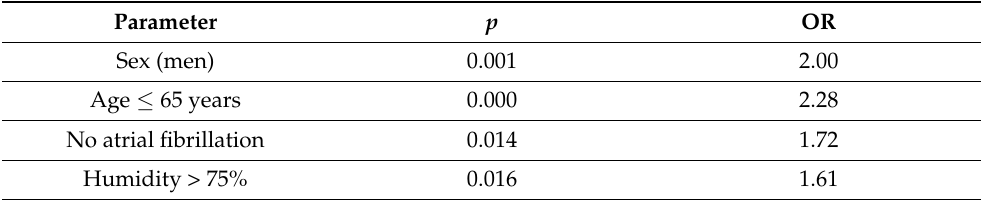
Table 3. Factors with a potential impact on the functional status ( ≤ 2 mRS) on the day of discharge from the Neurology